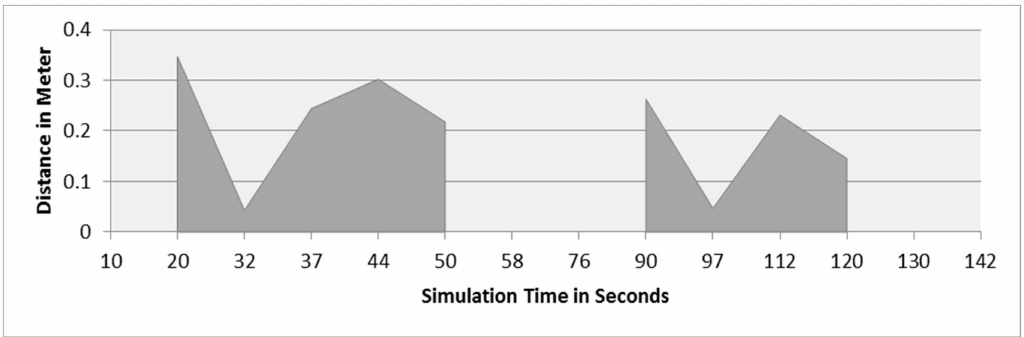
Figure 20. Distance to obstacles in meters at different simulation